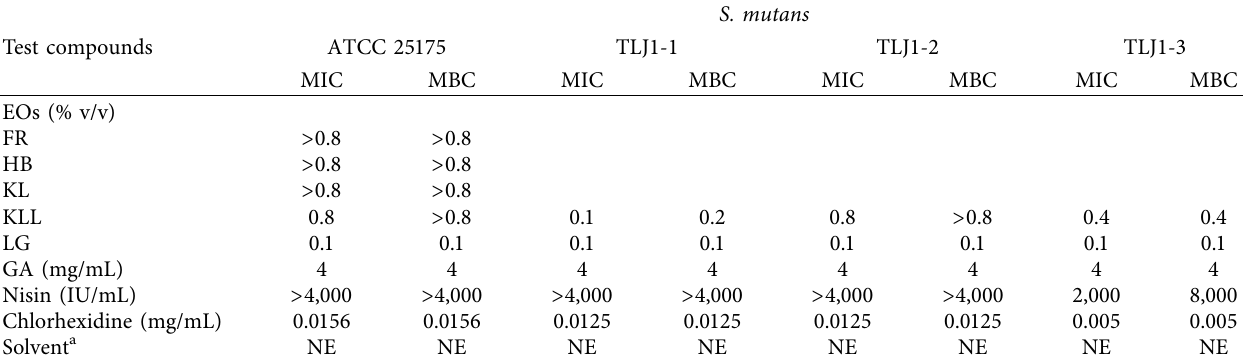
Table 2: Antibacterial activities of EOs, GA, and nisin against S. mutans ATCC 25175 and three clinical isolates.